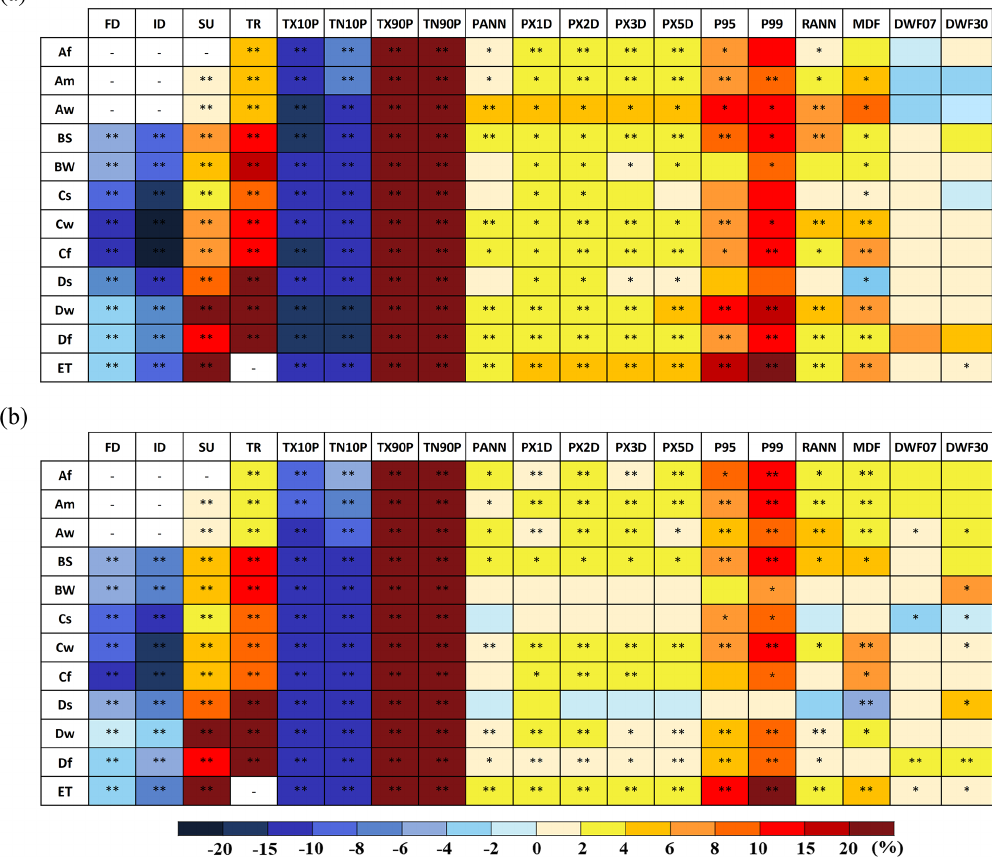
Figure 12. Plots of the percentage changes (%) in the climate extreme indices in response to additional warming of 0.5 ◦ C in the climate zones over Asia under (a) RCP4.5 and (b) RCP8.5, where “ ∗ ” and “ ∗∗ ” represent significance at the 80% and 100% levels,